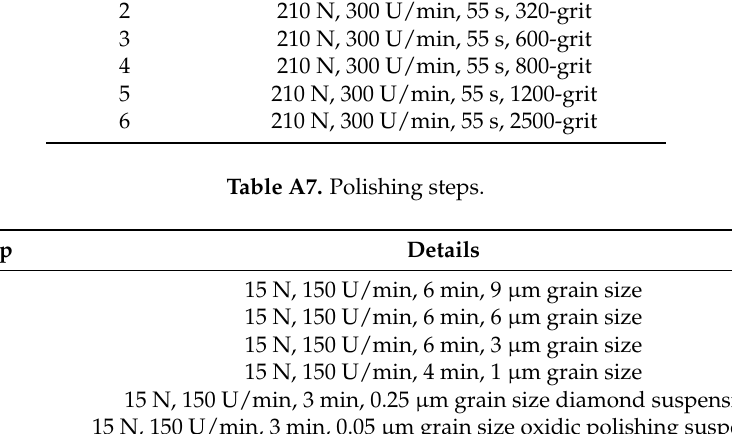
Table A8. Influence of grinding and polishing steps on the example of DP600.